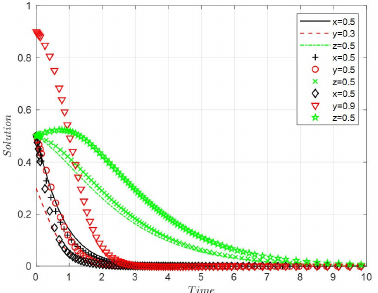
Figure 1. The evolutionary path of scenario